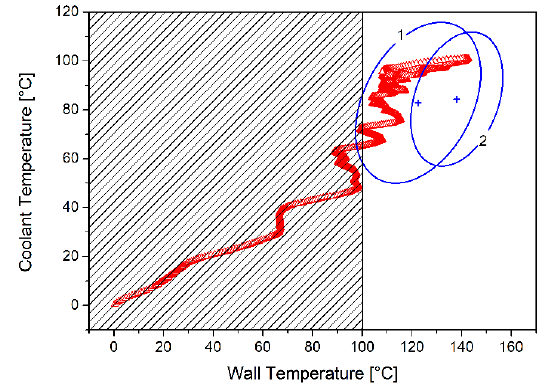
Figure 20. Coolant and wall temperatures during the NEDC starting from 0 °C environment.